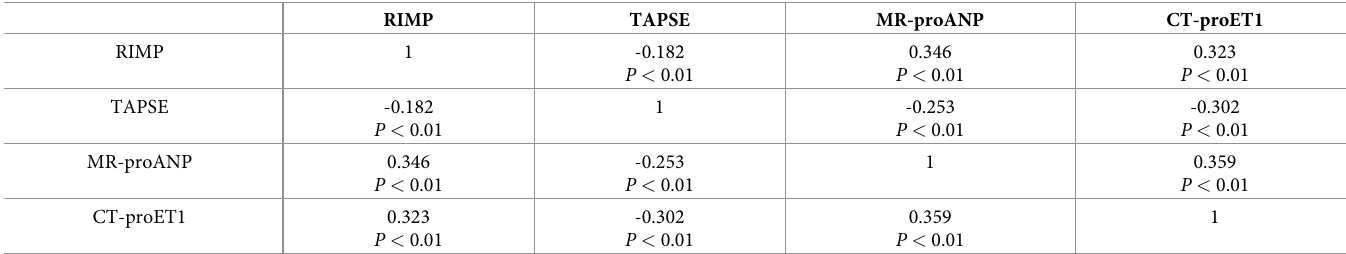
Table 3. Spearman correlation coefficients ( r S ) between echocardiographic measurements and vasoactive peptide serum